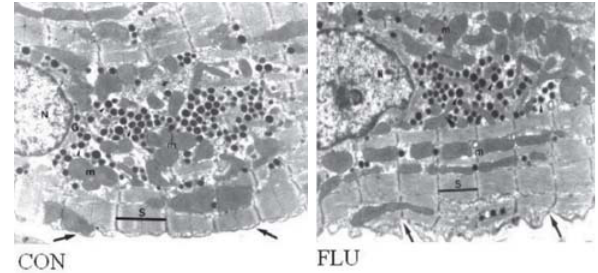
Fig 2 - Electron micrographs of ventricle cardiomyocytes sliced longitudinally. In CON and FLU groups, clearly sarcomere delimited by the Z lines (S), normal aspects of mitochondria (m), Golgi complex (G) and paranucleate granules with electron dark appearance (º%) were identified. Note the sarcoplasmic membrane integrity with a regular aspect (arrows).